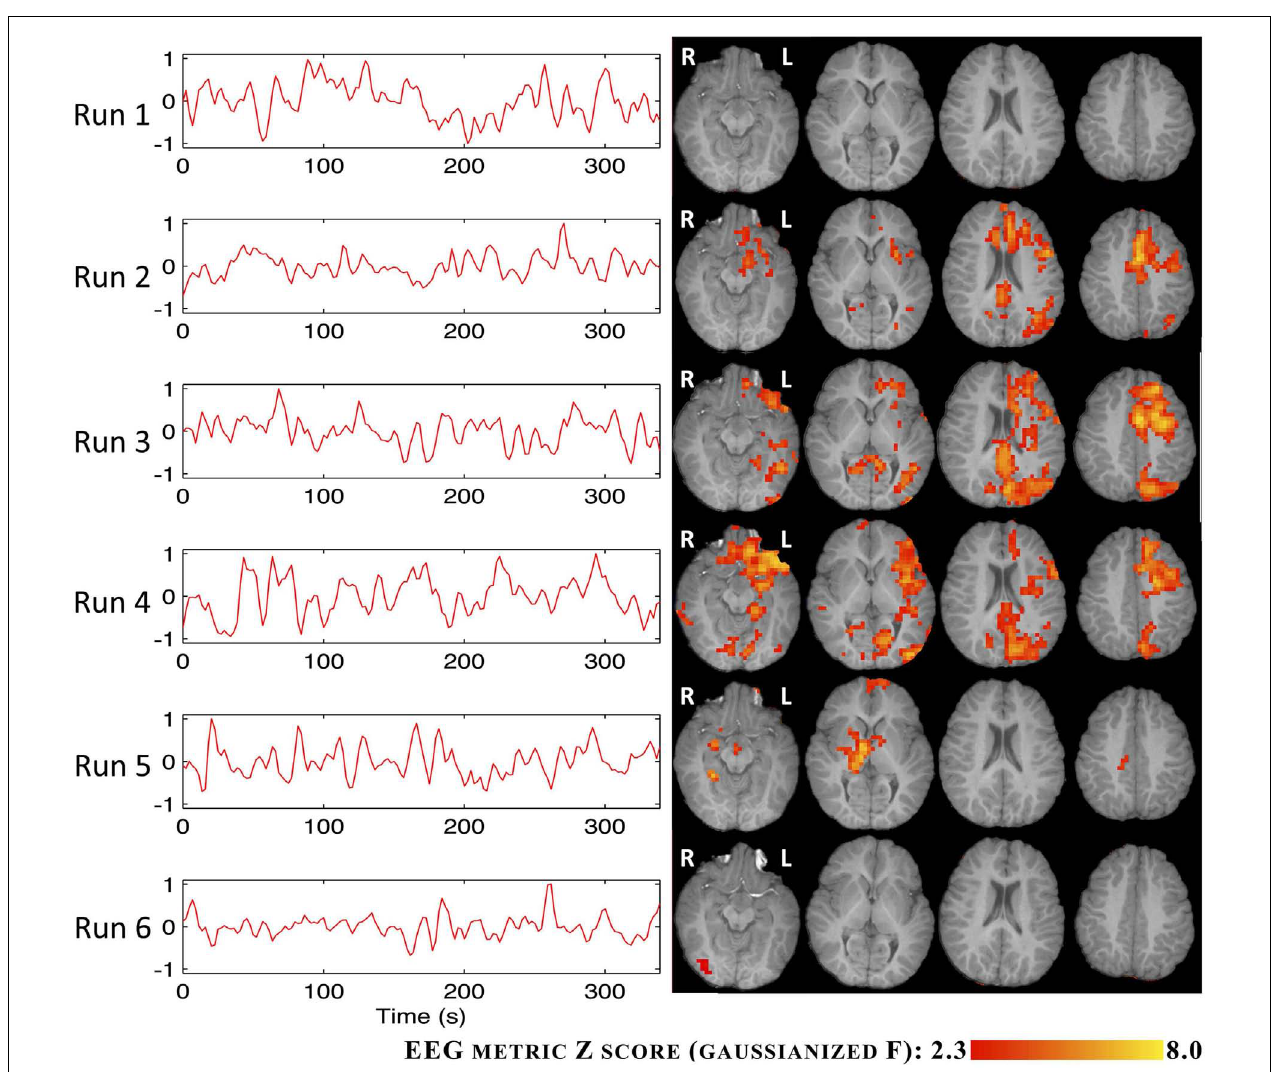
FIGURE 7 |Time courses (left) and Z statistic maps (right) of the RMSF metric for IC